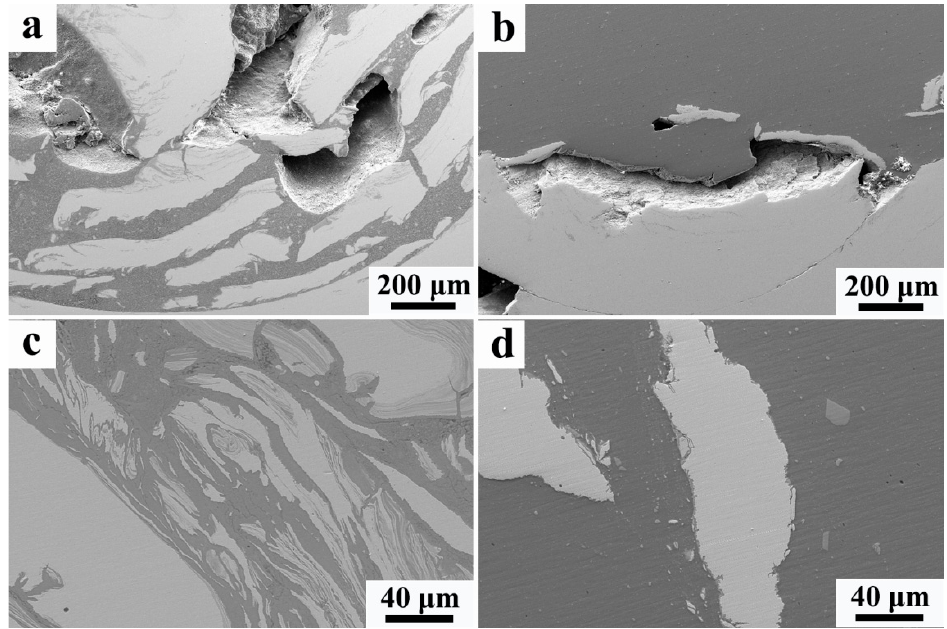
Figure 6. The welding defects of ( a ) FSW and ( b ) UaFSW joint and the broken steel particles in the ( c ) FSW and ( d ) UaFSW joint observed at the bottom of the NZ.